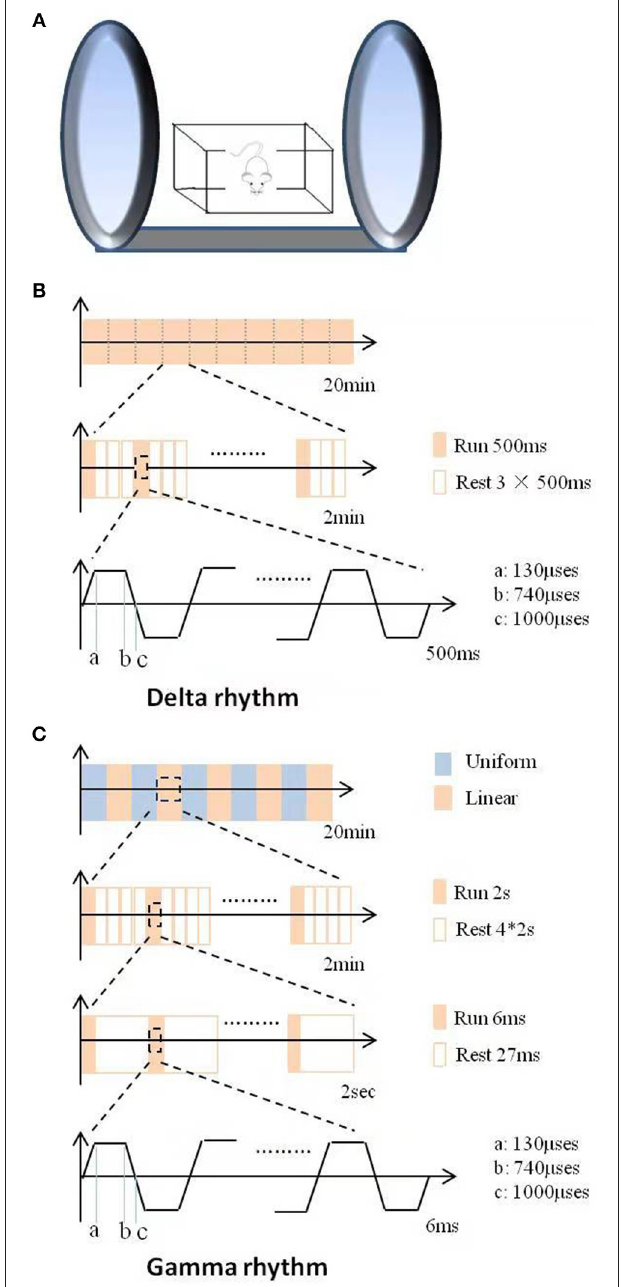
FIGURE 1 | Schematic illustration of the DMS apparatus and stimulus patterns used in this study. (A) The apparatus and operational principle of DMS. (B) The stimulus pattern of LFS with delta rhythm. (C) The stimulus pattern of HFS with gamma